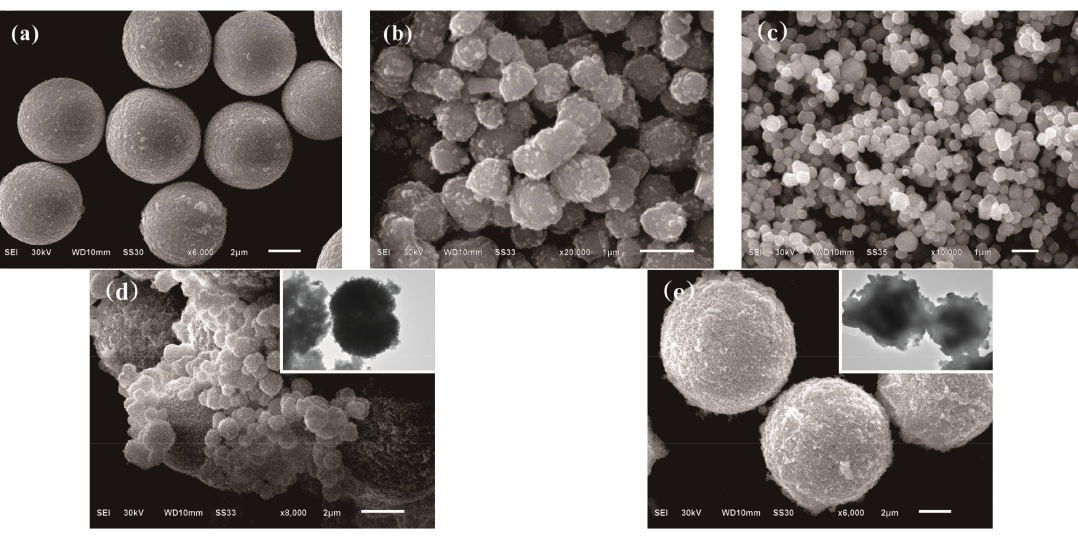
Figure 2. Scanning electron microscopy (SEM) images of photocatalysts, ( a ) CuBi 2 O 4 ; ( b ) Ag 3 PO 4 -SC; ( c ) Ag 3 PO 4 -SS; ( d ) CuBi 2 O 4 /Ag 3 PO 4 -SC; ( e ) CuBi 2 O 4 /Ag 3 PO 4 -SS. The illustrations in ( d , e ) indicate the high-resolution transmission electron microscopy (HRTEM) images of CuBi 2 O 4 /Ag 3 PO 4 -SC and CuBi 2 O 4 /Ag 3 PO 4 -SS,